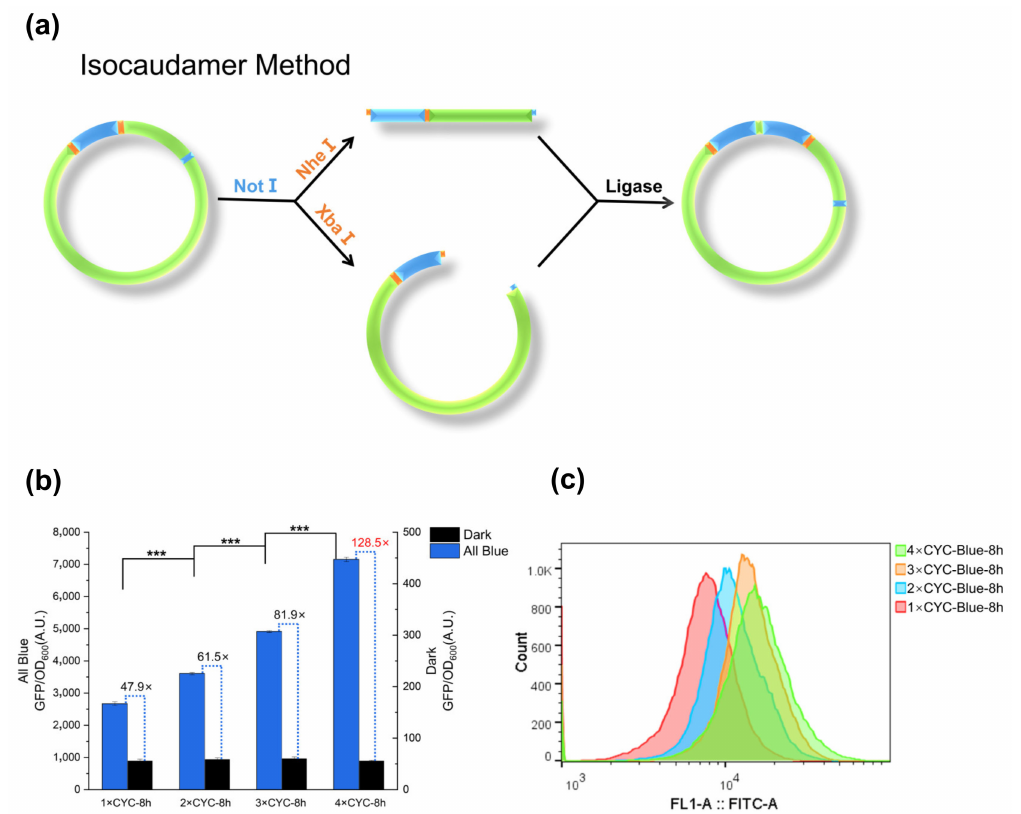
Figure 2. Design, optimization and validation of the single-component optogenetic system. ( a ) Construction of multiple copies of response fragments by the isocaudamer method. The cyan part represents the response fragment. ( b ) Strains harboring response fragments with different copies from 1 to 4 (1~4 × CYC) were cultured for 8 h with or without blue light. ( c ) Flow cytometry detection of strains carrying different plasmids after induced to the highest fluorescence intensity under blue light. Error bars indicate Means ± S.D. (n = 3); Significance of differences between all blue induced states: *** p <